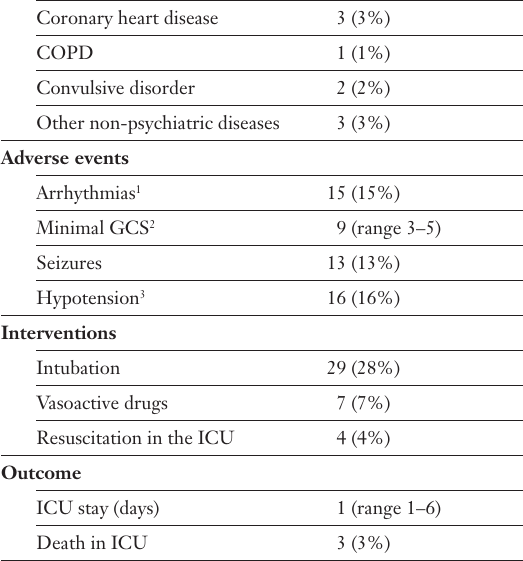
Co-morbidities, ad- verse events, inter- ventions and out- come of the 103 pa- tients with presumed antidepressant intox-